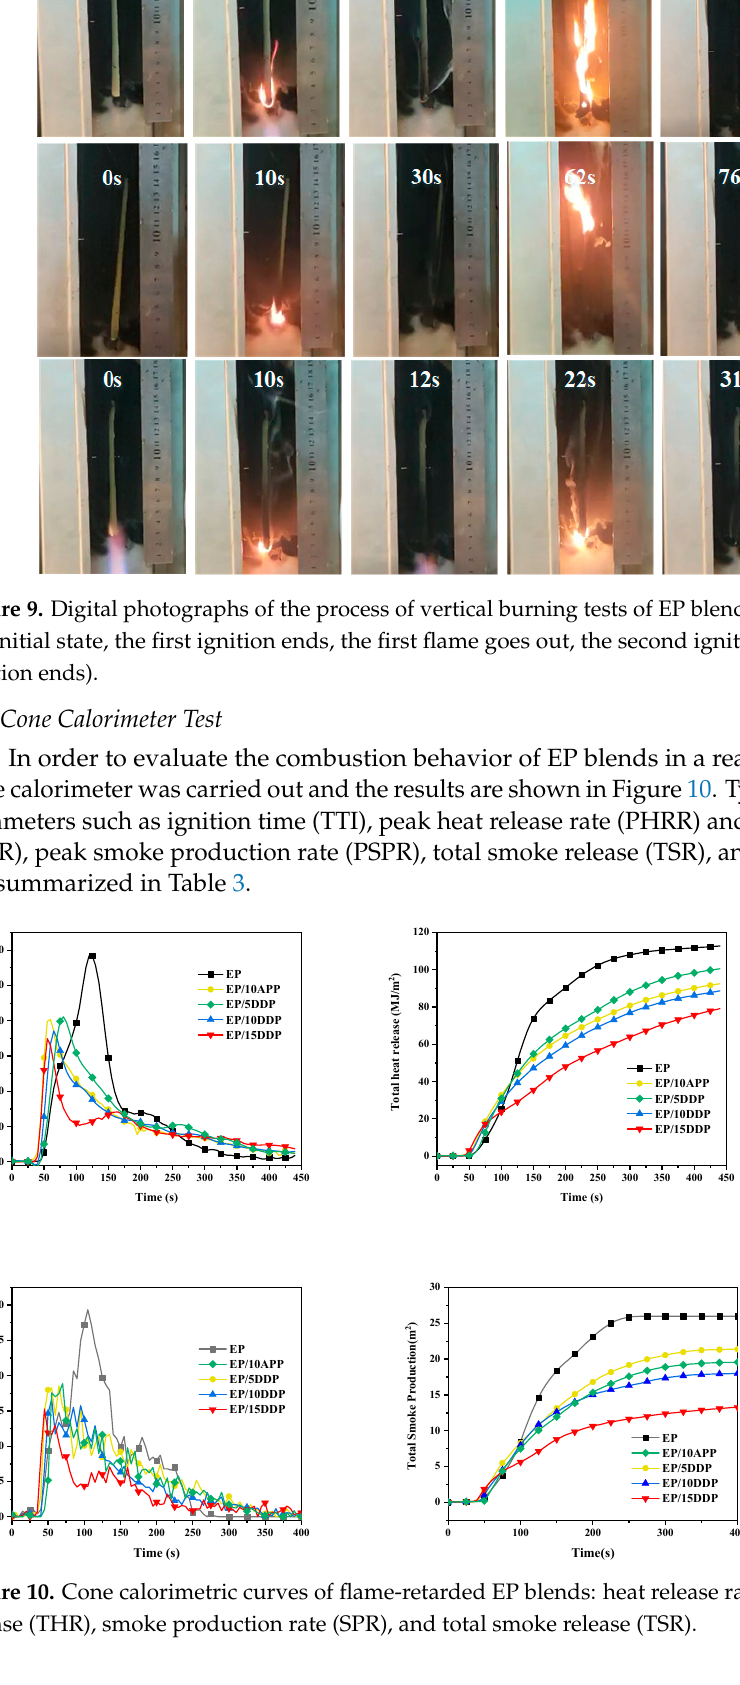
Figure 10. Cone calorimetric curves of flame-retarded EP blends: heat release rate (HRR), total heat release (THR), smoke production rate (SPR), and total smoke release (TSR).